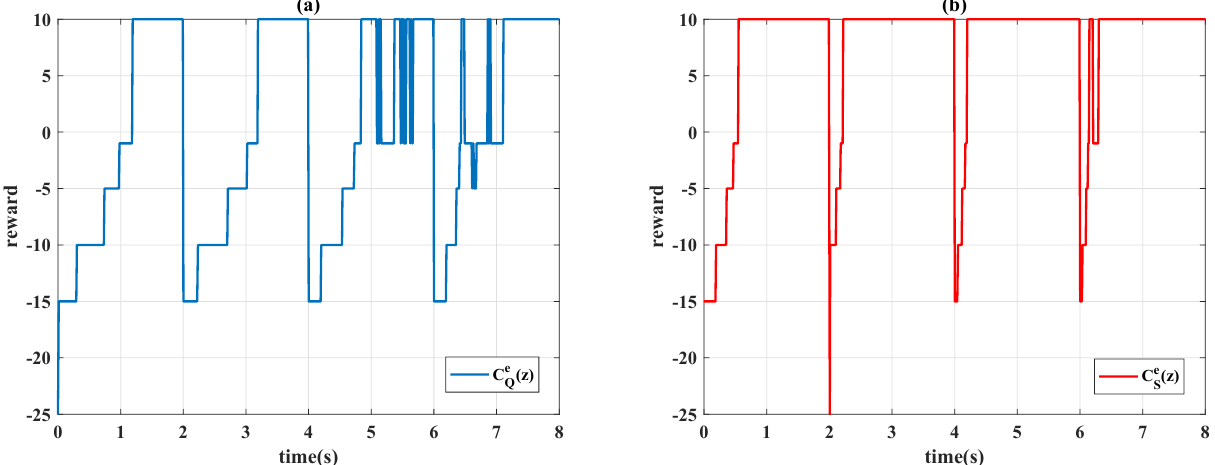
( z ) ; ( b ) Sarsa C e Q